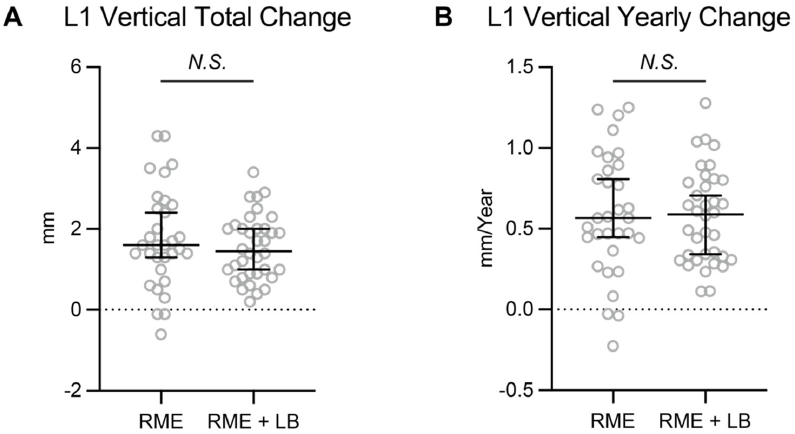
Figure 4. The ( A ) total change and ( B ) yearly change of the mandibular central incisors’ vertical position. The data are presented as raw data overlapped with Median ± 95% confidence interval. RME: rapid maxillary expansion; LB: lip bumper; N.S. : not